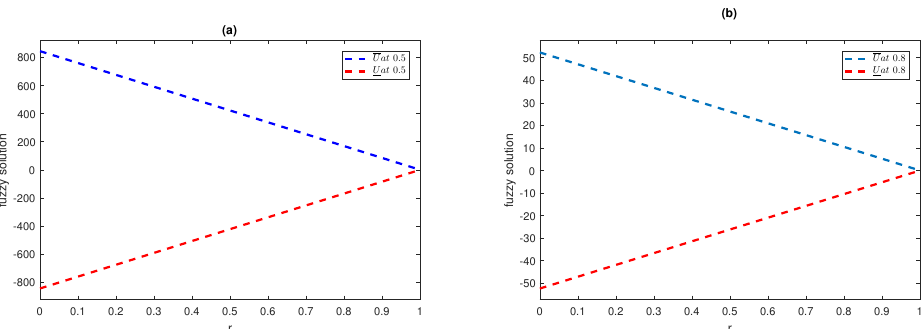
Figure 4. 2-D fuzzy upper and lower portion simulation of semi-analytical series solution up to first four terms at x 1 = x = 0.8, τ = t = 0.5, x 2 = y = 0.5, and for different fractional orders of Example